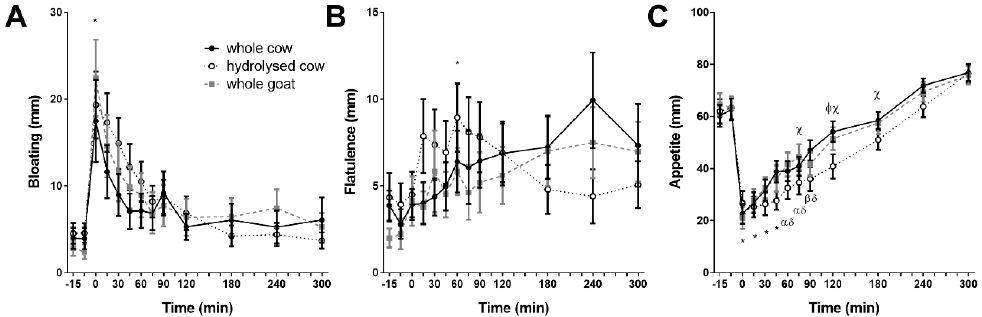
Figure 5. Postprandial subjective digestive symptom and appetite responses. Bloating ( A ), flatulence ( B ), and appetite ( C ). Values represent means ± SEM on a 100 mm scale. Symptom scales were anchored with 0 “no symptom” and 100 “the most severe symptom imaginable”. Appetite was anchored with 0 “nothing at all” and 100 “a lot” in response to “How much do you think you can eat?”. There was a time × treatment interaction for appetite ( p < 0.001). Φ denotes statistical significance p < 0.05 between whole goat (WG; █ ) and hydrolysed cow (HC; ○ ) fortified milks; χ p <